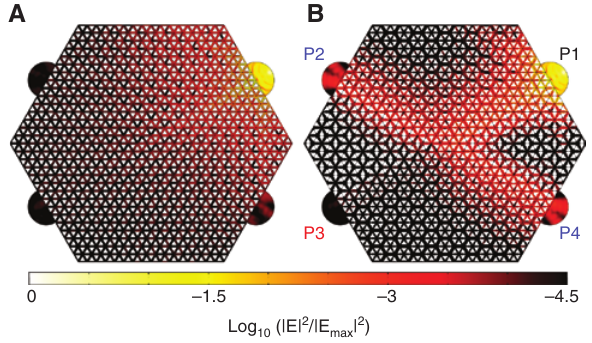
Figure 3: Energy distribution in design domain. The max-normalized energy distribution in the design set-up for the initial crystal (A) and final photonic topological insulator (PTI) crystal configuration (B) shows a transmission improvement to ports P2 and P4 by orders of magnitude. The slab is excited by a TE-polarized point source at P1 oscillating at 184 THz.